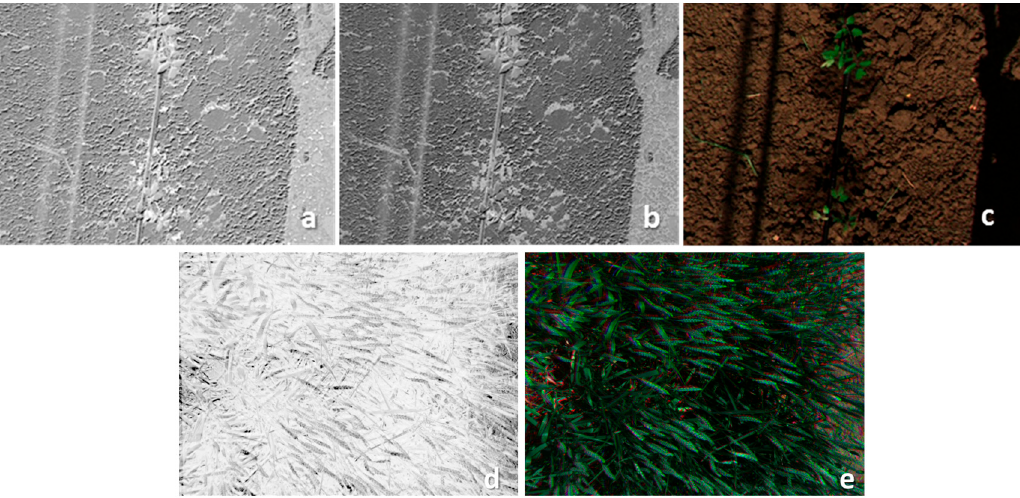
Figure 16. Illustrations of NDVI ( a , tomato; d , durum wheat), GDVI ( b , tomato), and RGB images ( c , tomato; e , durum wheat) obtained from the sensors of MAIA spectral camera.